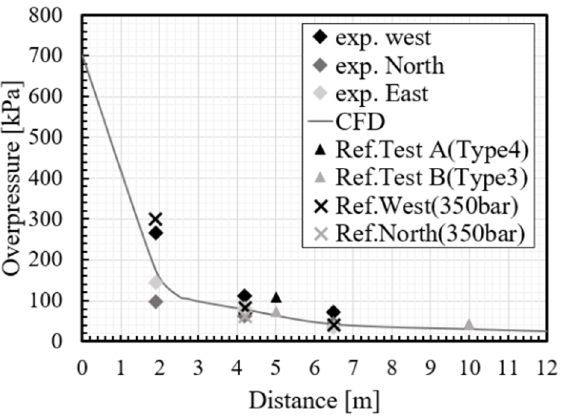
Figure 12. Comparison of maximum overpressures generated by hydrogen tank explosions. Table 3. Capacities, filling pressures, and overpressure conditions of hydrogen tank explosions.